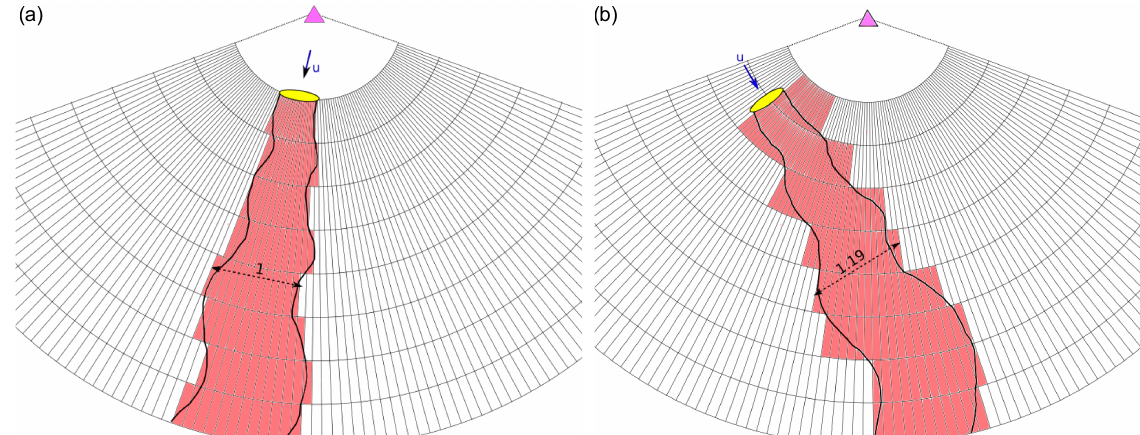
Figure 10. Qualitative sketch of the dependence of detected wake width on the orientation of the coordinate grid used by a scanning lidar (purple triangle) as a function of the wind direction. Panel (a) shows the case of a wake aligned with the line of sight from the scanning lidar (wind direction shown by the blue arrow), while panel (b) shows the case of a wake not aligned with the line of sight from the lidar. The dashed arrow highlights the difference in the detected wake width for the two cases, at fixed downwind distance from the turbine (yellow ellipse).